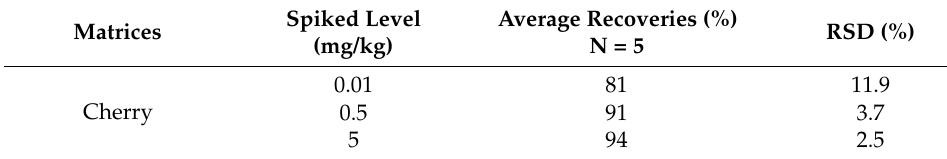
Table 2. Recoveries ( n = 5) of fludioxonil in cherry samples.